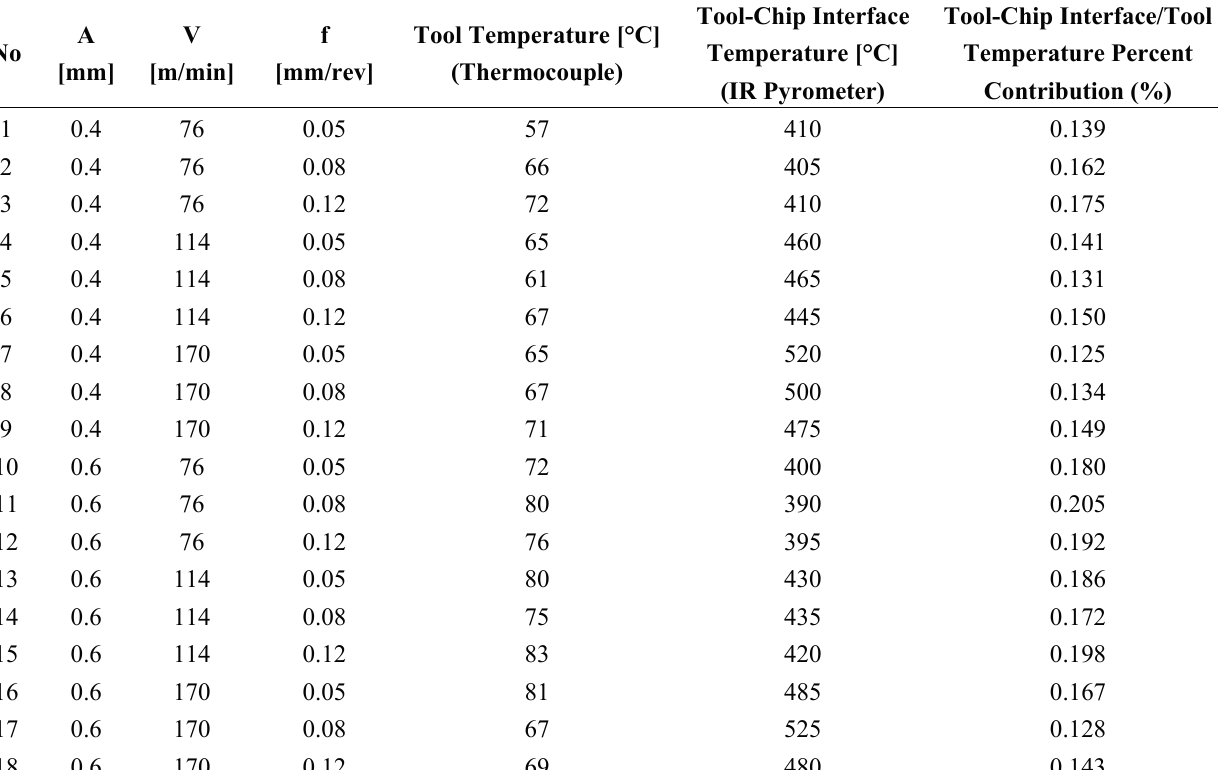
Table 5. Experimental